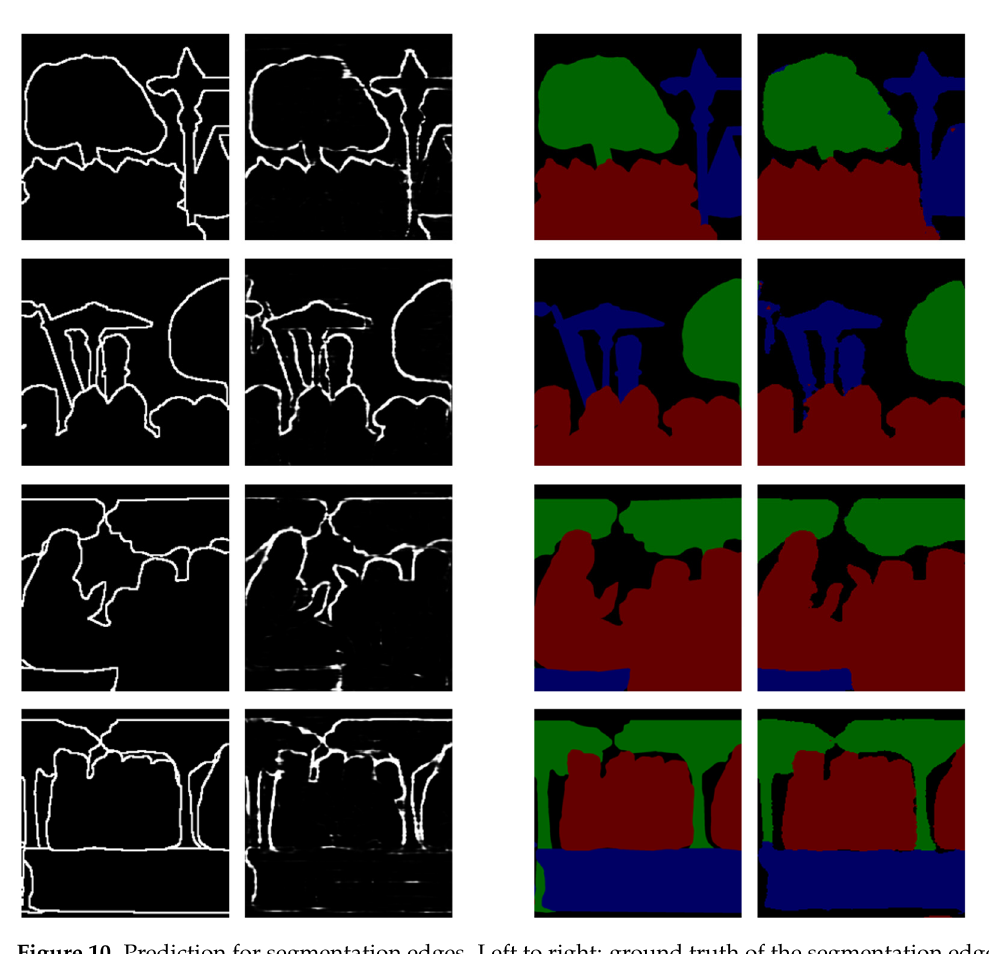
Figure 10. Prediction for segmentation edges. Left to right: ground truth of the segmentation edge, prediction results of the segmentation edge, ground truth of semantic segmentation, and prediction results of semantic segmentation. The results show that the network can predict approximate segmentation edges and is consistent with the prediction results of semantic segmentation.